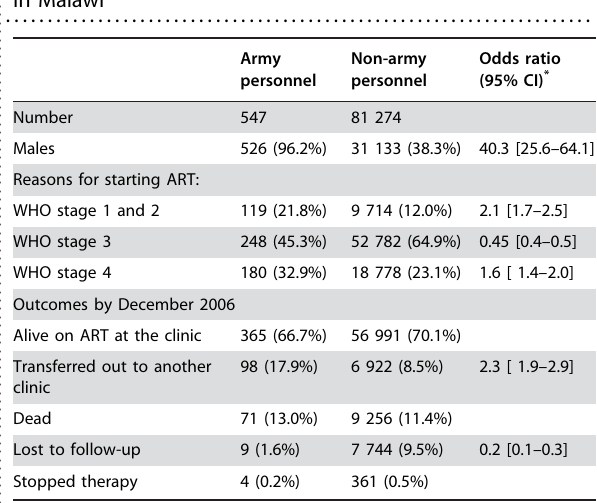
Table 2. Demographic, clinical features and treatment outcomes censored on December 31 st 2006 in army personnel and non-army personnel starting free ART in the public sector